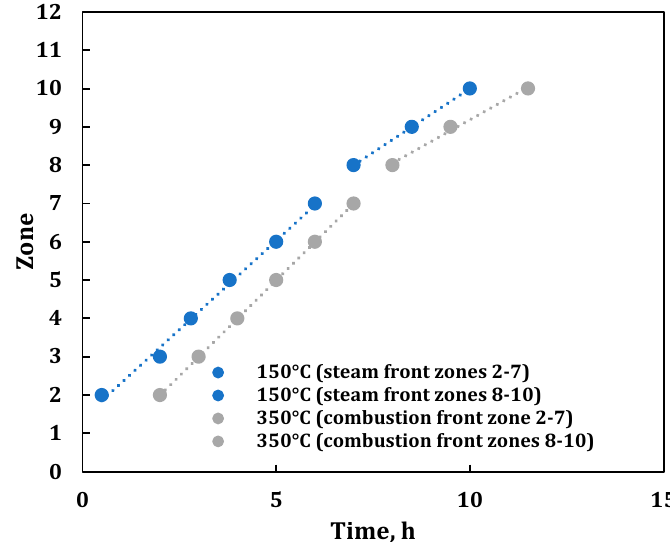
Figure 8. Steam and combustion fronts for vuggy CT test.